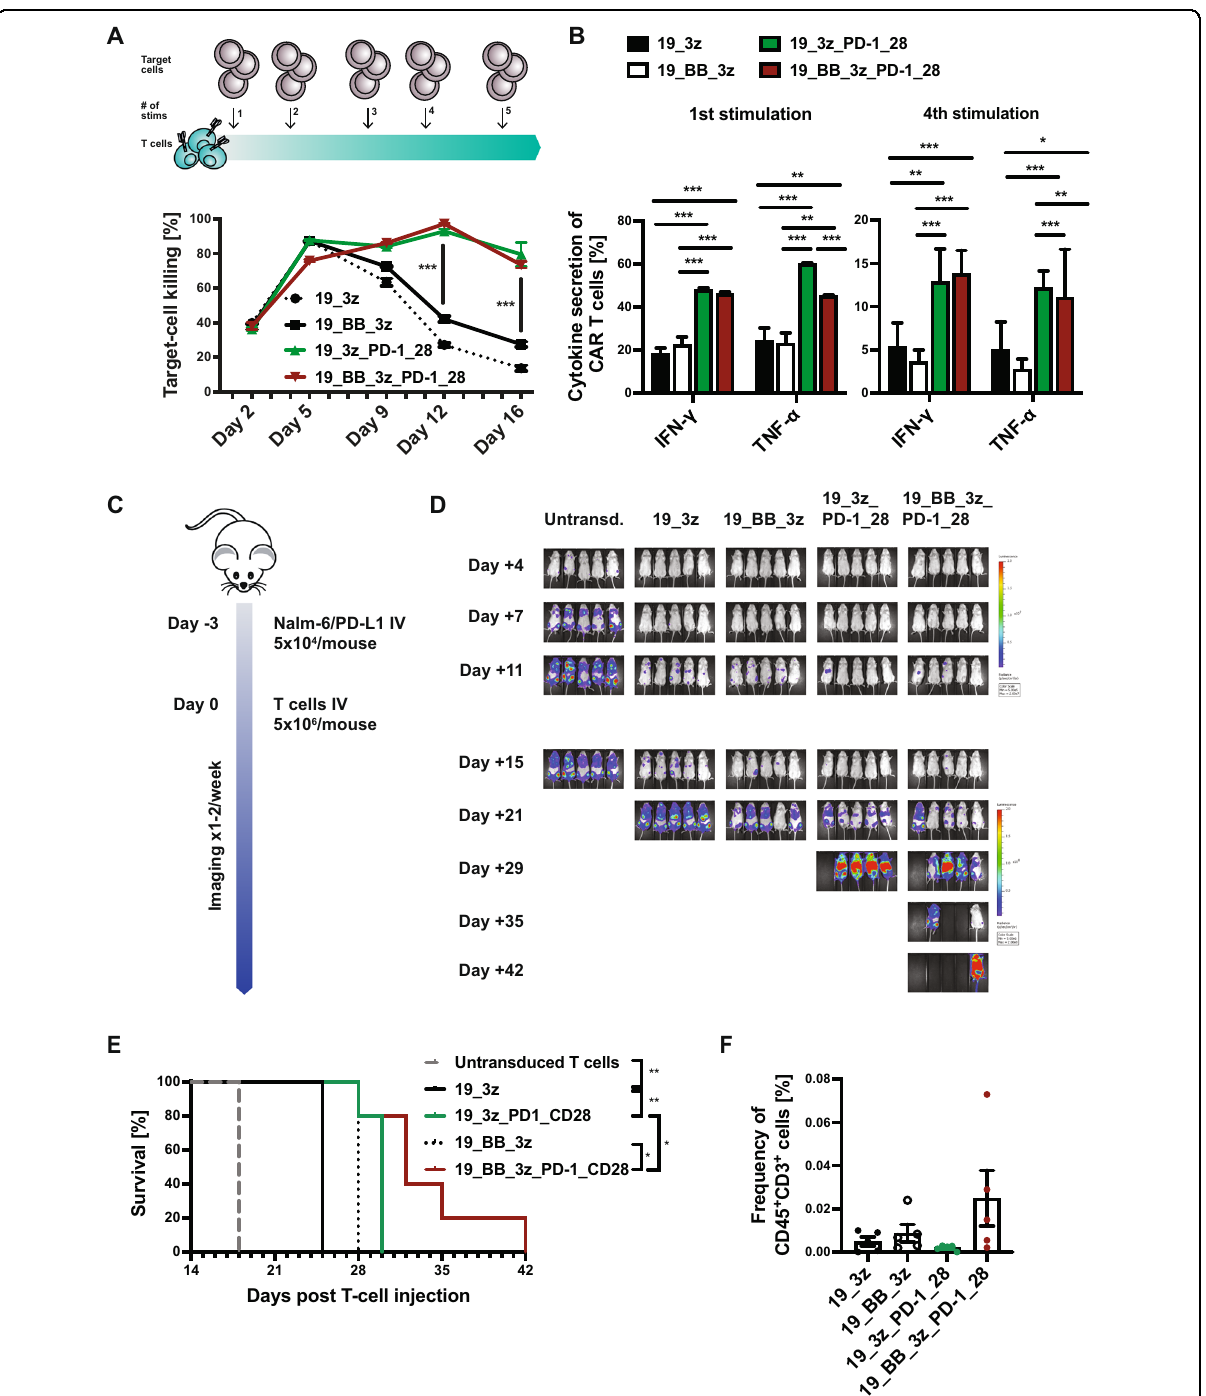
Fig. 2 Functionality of PD-1-CD28 CAR T cells after multiple antigen encounter and in vivo. A Schematic illustration and cytotoxicity curves of the multiple stimulation assay. T cells were stimulated with fresh target cells (Daudi) every 3 to 4 days. Killing of freshly added target cells at every re- stimulation timepoint was determined by fl ow-cytometry-based cytotoxicity assay. Exemplary plot for one donor shown, second donor is shown in Supplementary Fig. 5. B Intracellular cytokine stain of CAR T cells was performed 24 h after fi rst and 24 h after fourth re-stimulation. C Schematic illustration of the leukemia model used to evaluate in vivo functionality. 5 × 10 6 CAR T cells were injected 3 days after injection of 5 × 10 4 Nalm-6 cells with PD-L1 overexpression. D Bioluminescence imaging was performed once to twice per week until day + 39 after T-cell injection. Days after T-cell injection are shown. E Survival analysis of mice, which received untransduced T cells, conventional fi rst- and second-generation CAR T cells or CAR T cells with fusion protein. F Frequency of CAR + CD45 + CD3 + (CAR) T cells was analyzed by fl ow-cytometry on day + 22 after T-cell injection. N = 5 mice per group. Statistical signi fi cance was calculated using t -test ( A , B ) or Log-rank (Mantel-Cox) test ( E